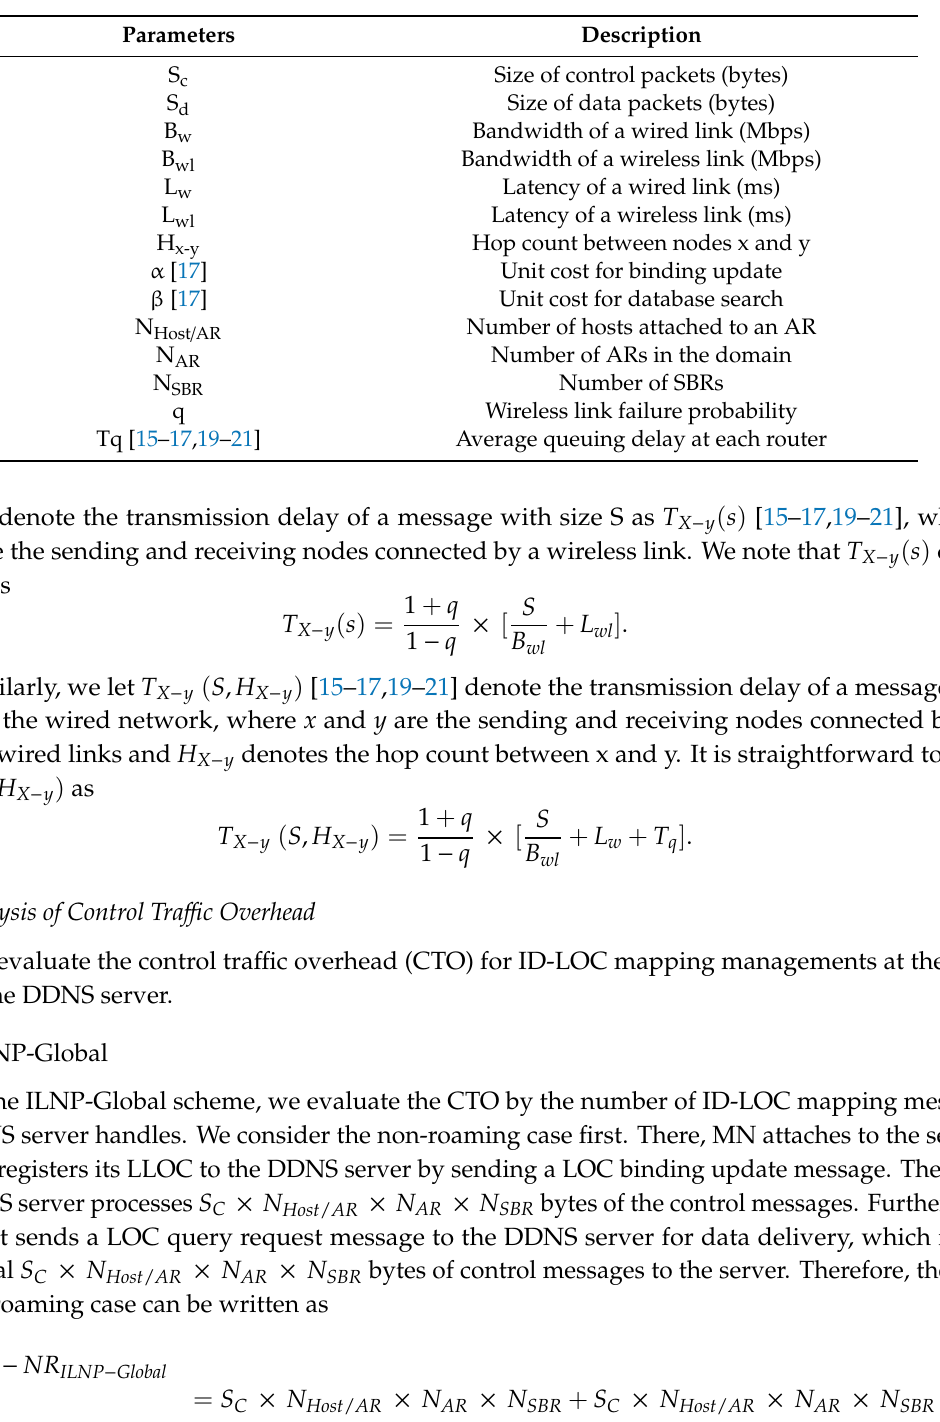
Table 4. Parameters used for cost